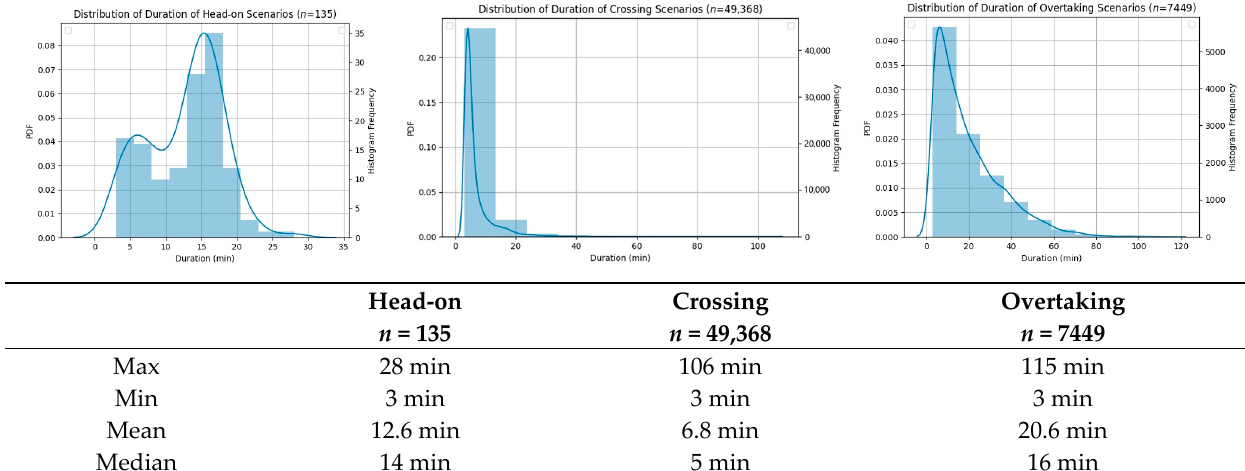
Figure 8. Distribution of duration time for different encounter scenarios.